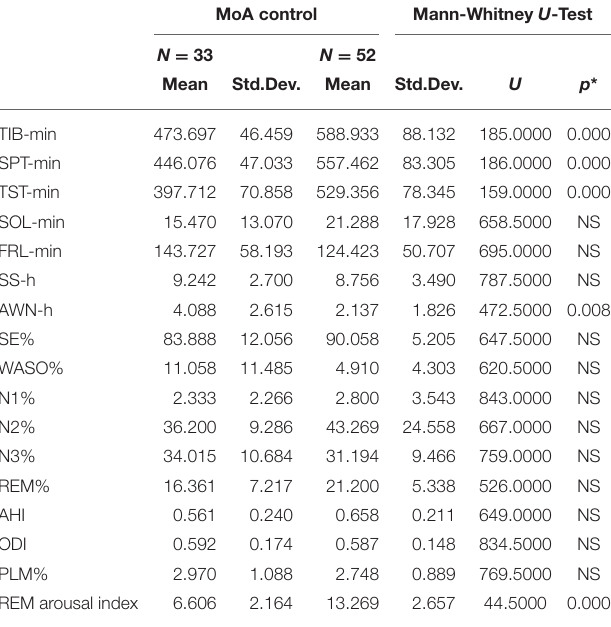
TABLE 3 | The mean differences, evaluated with the Mann-Whitney- U test, TABLE 2 | Polysomnographic sleep macrostructure findings in MoA and normal among children affected by migraine without aura (MoA) and control group in the control group. following parameters: CAP refers to cyclic alternating pattern; CAP rate MoA control Mann-Whitney U -Test (percentage of total NREM sleep time occupied by CAP sequences); percentage and duration of each A phase subtype; A1 index (number of phases A1 per hour of NREM sleep, and of N1, N2, and N3 sleep stage); A2 index (number of